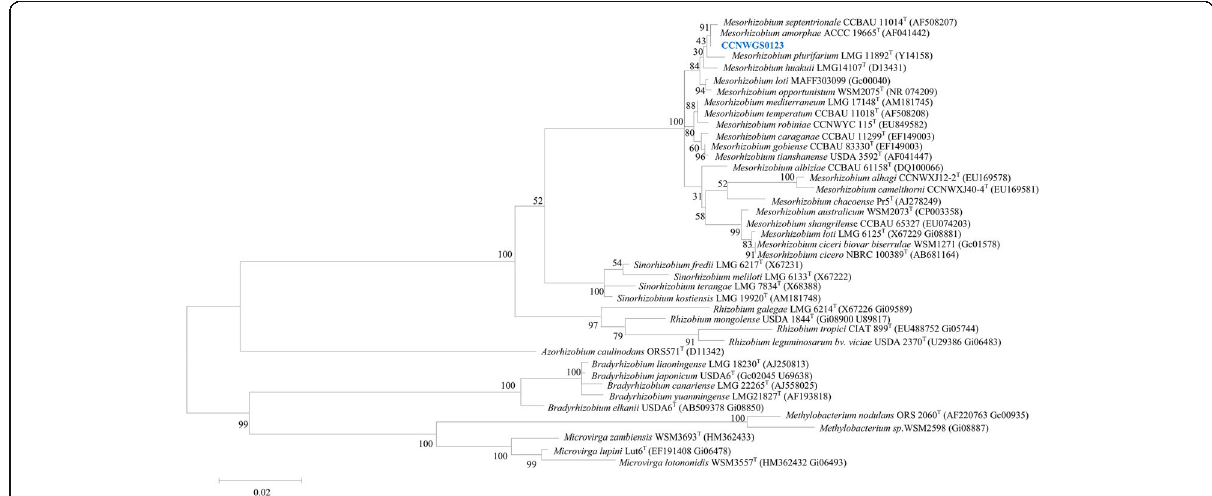
Fig. 2 Phylogenetic tree showing the relationships of Mesorhizobium amorphae CCNWGS0123 with other root nodule bacteria based on aligned sequences of a 1296 bp internal region of the 16S rRNA gene. All sites were informative and there were no gap-containing sites. Phylogenetic analyses were performed using MEGA, version 6 [15]. The tree was built using the Maximum Likelihood method based on the Tamura-Nei